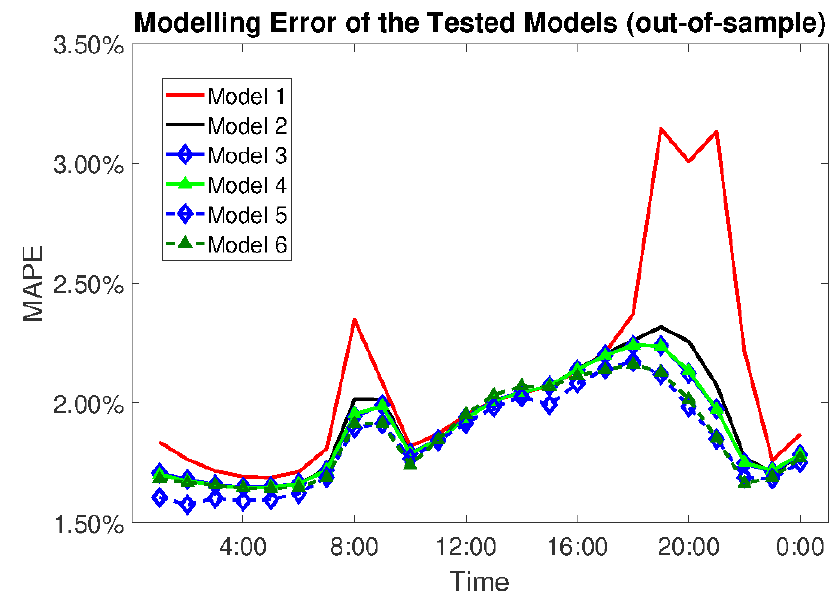
Figure 4. Average modeling error by time of day with out-of-sample